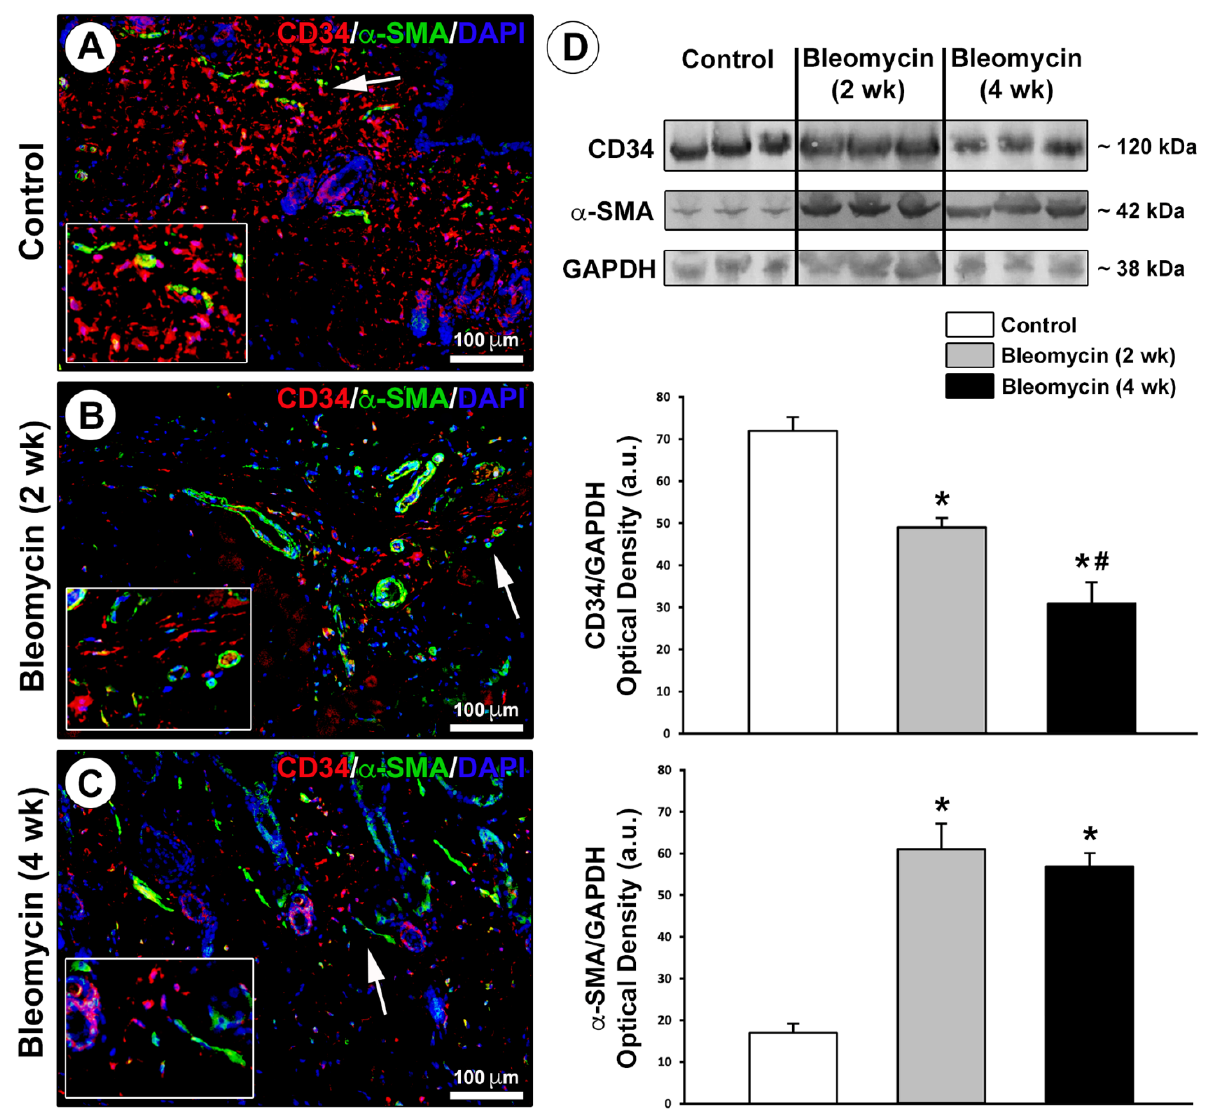
Figure 3. Changes in the expression of CD34 and α -smooth muscle actin ( α -SMA) in the skin of bleomycin-treated mice. ( A – C ) Representative photomicrographs of skin sections from ( A ) control mice and ( B , C ) mice treated with subcutaneous injections of bleomycin for 2 weeks (early disease stage) or 4 weeks (sclerotic skin) subjected to double immunofluorescence staining for CD34 (red) and α -SMA (green) and 4 ′ ,6-diamidino-2-phenylindole (DAPI; blue) counterstain for nuclei. Insets in ( A – C ) represent higher magnifications of the dermal tissue areas pointed by arrows. In control mouse skin, telocytes (TCs)/CD34 + stromal cells form a widespread dermal network and do not express α -SMA, which is detectable only in microvascular structures ( A ). The dermis of mice treated with bleomycin for 2 or 4 weeks is characterized by a substantial reduction in TCs/CD34 + stromal cells along with the presence of some α -SMA + myofibroblasts; a few stromal cells co- expressing CD34 and α -SMA are observed only in the skin of mice treated with bleomycin for 2 weeks ( B , C ). Scale bar: 100 μ m ( A – C ). ( D ) Western blotting analysis of CD34 and α -SMA protein expression in skin lysates from control mice and mice treated with subcutaneous injections of bleomycin for 2 or 4 weeks. Representative immunoblots are shown at the top. Glyceraldehyde 3-phosphate dehydrogenase (GAPDH) was measured as a loading control. Molecular weight values (kDa) are indicated on the right. Results of densitometric analysis of the bands are shown at the bottom. Columns represent the mean, and whiskers represent the standard error of the mean; n = 6 mice in each group. * p < 0.001 vs. control, # p < 0.01 vs. bleomycin (2 wk) (Tukey’s test). wk, weeks.